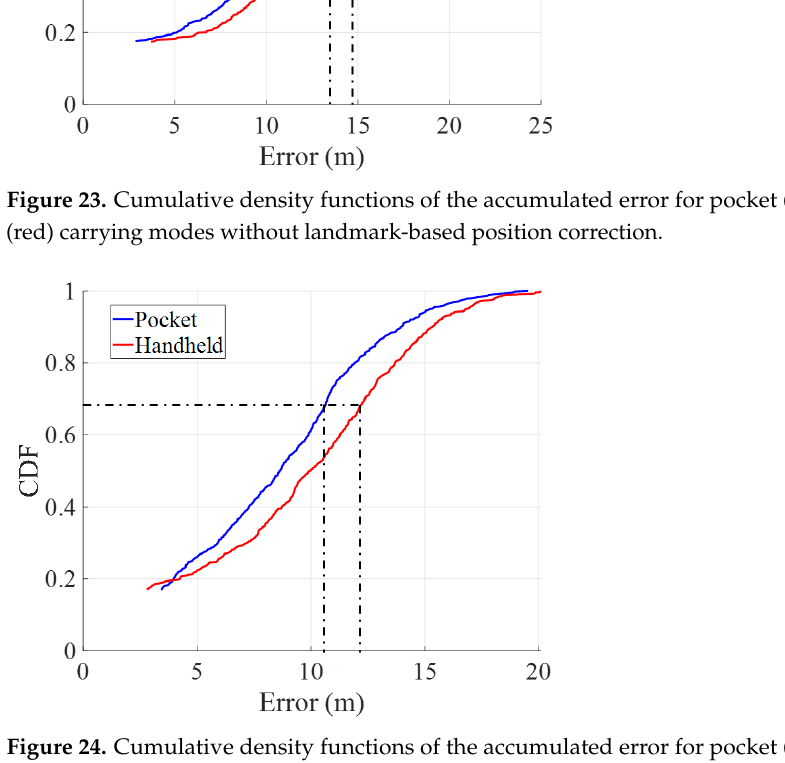
Figure 24. Cumulative density functions of the accumulated error for pocket (blue) and handheld (red) carrying modes with landmark-based position